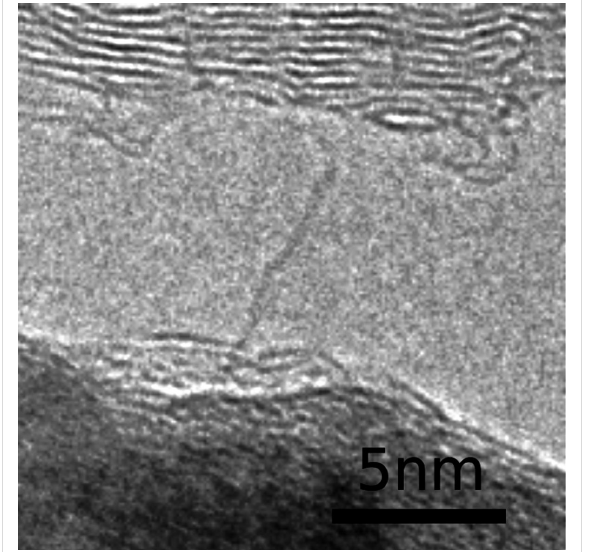
Figure 3: A carbon chain spanning between an iron crystal (bottom) and a graphitic aggregate (top). Both act as electrodes so that the electrical properties of the chain can be measured. Reprinted with permission from [23]. Copyright 2013 American Chemical